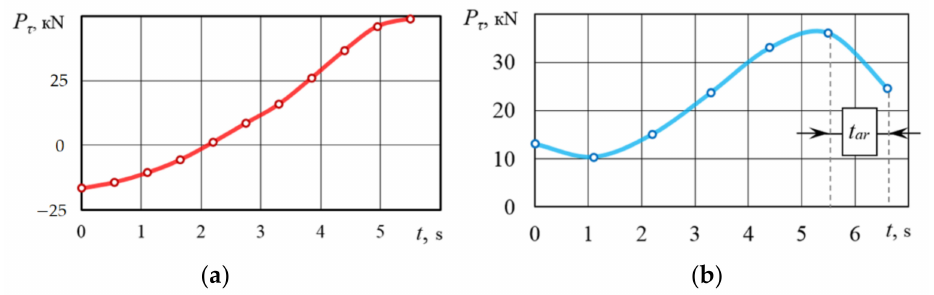
Figure 7. Change in the traction force on the rotor during the half-cycle: ( a ) 1 − V s = 104 m/h, V c = 6 m/s, t ar = 0 s; 2 − V s = 104 m/h, V c = 9 m/s, t ar = 0 s; ( b ) V s = 104 m/h, V c = 6 m/s, t ar = 1.1